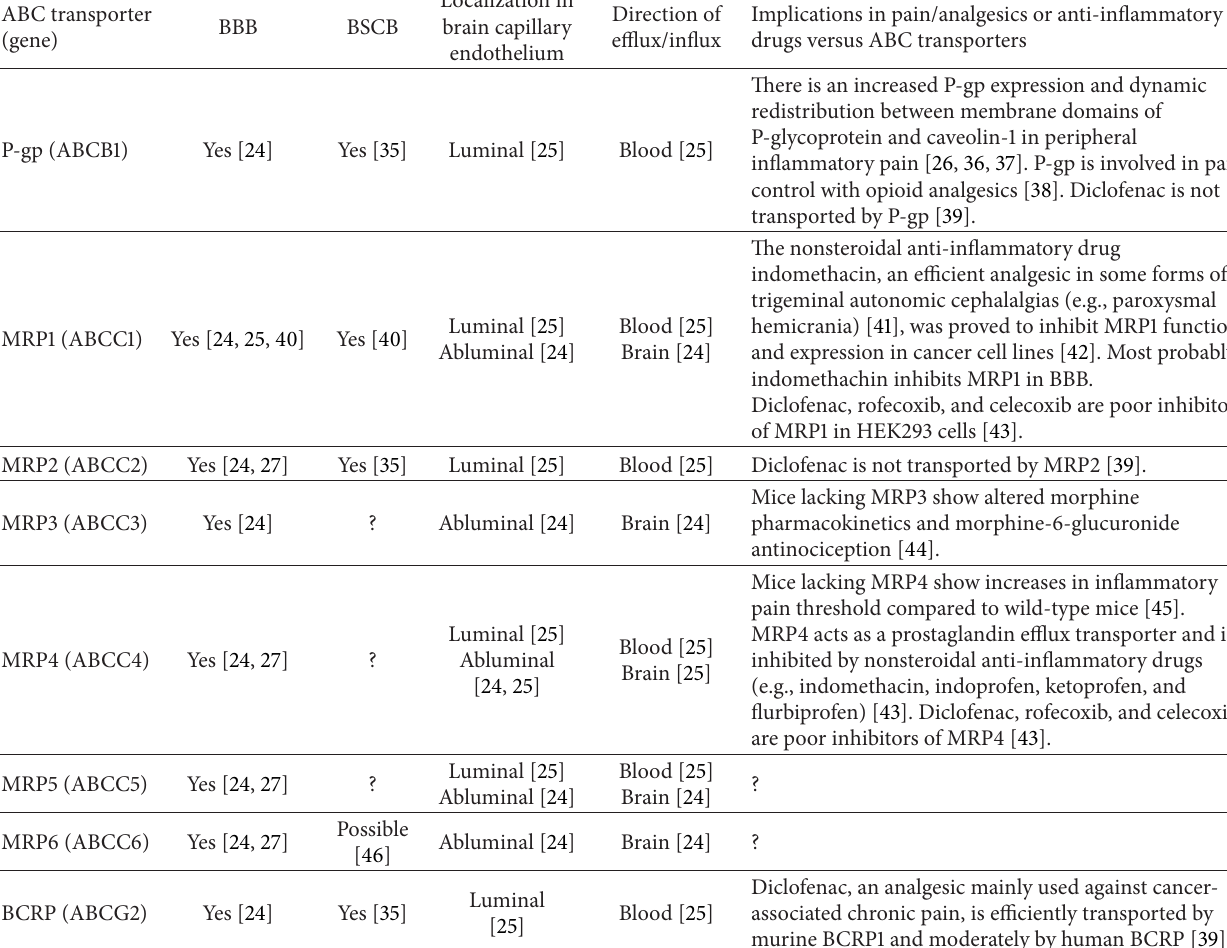
Table 1: ABC transporters presence in BBB and BSCB and their potential role in